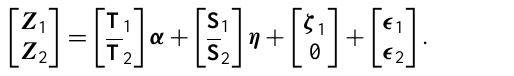
Figure 8. FRK nodes or center locations of 93 basis functions at three spatial resolutions. The first resolution is 40km, the second resolution is 20km, and the third resolution is